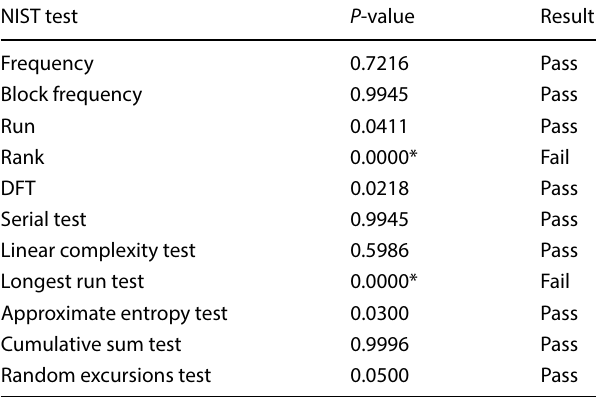
Table 6 NIST statistical test results for TRNG (FAT-1)